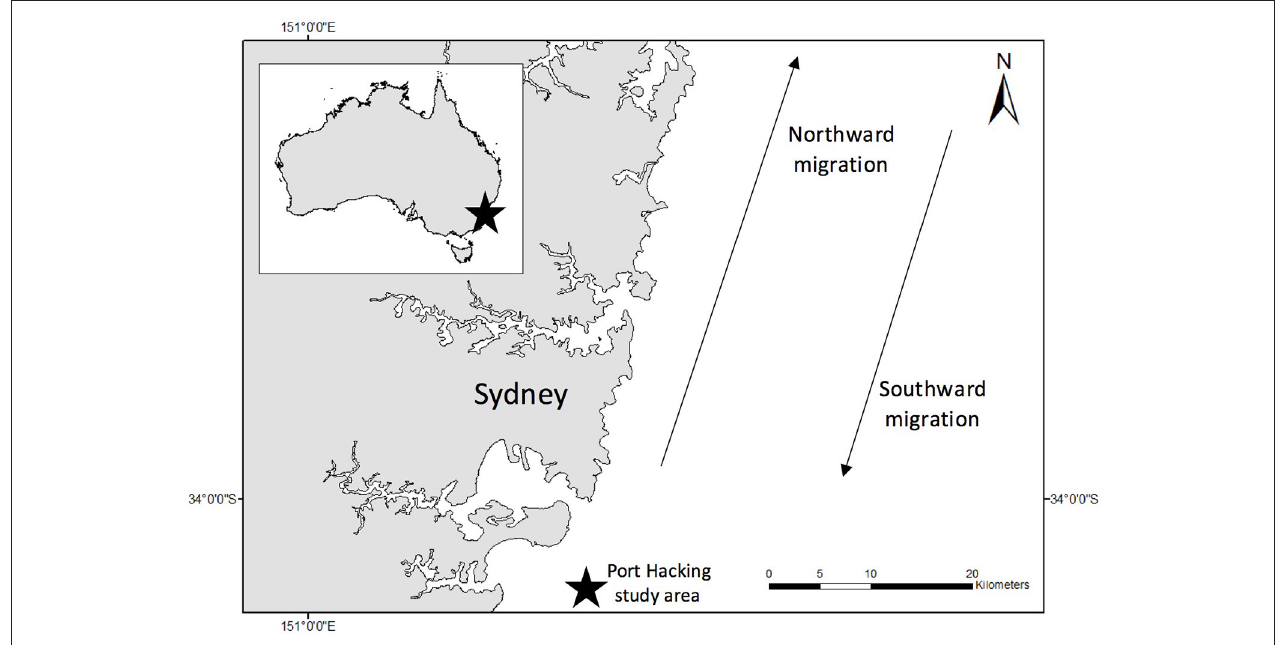
FIGURE 1 | Study site (indicated by black star on insert). All samples were collected in coastal waters ( < 3nm) off Sydney, Australia. Blow samples were collected only from northward migrating East coast Australian humpback whales. Water samples were collected over a number of years from Port Hacking (indicated by star outside of